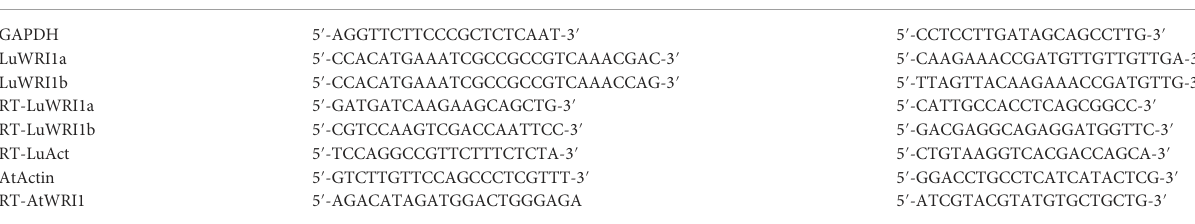
TABLE 1 Primers utilized in